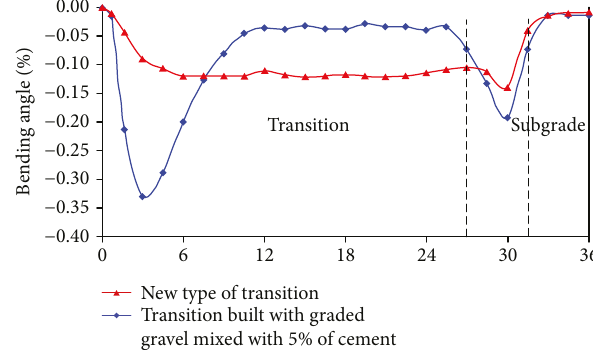
Figure 15: Diagrams for longitudinal distribution of rail-surface bending angle. Note: the place between two dotted lines is de fi ned as the transition-subgrade section in this paper.